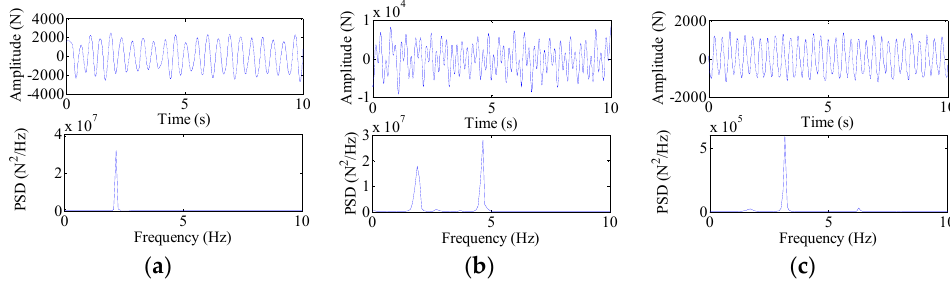
Figure 9. Fluctuation characteristic of F X acting on the wind rotor in different parking positions when the wind direction is β = 135 ˝ : ( a ) θ = 0 ˝ parking position; ( b ) θ = 30 ˝ parking position; ( c ) θ = 60 ˝ parking position.